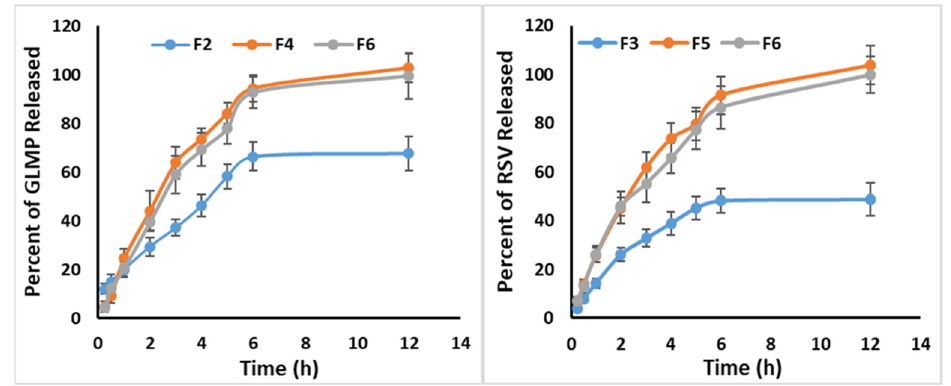
Figure 3. In vitro drug release of glimepiride and rosuvastatin from the prepared 3DP tablet for- mulations.